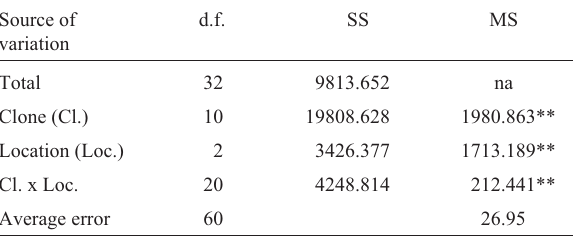
Table 1 - ANOVA for stability of tree dryness in Hevea brasiliensis . Source of variation Clone (Cl.)